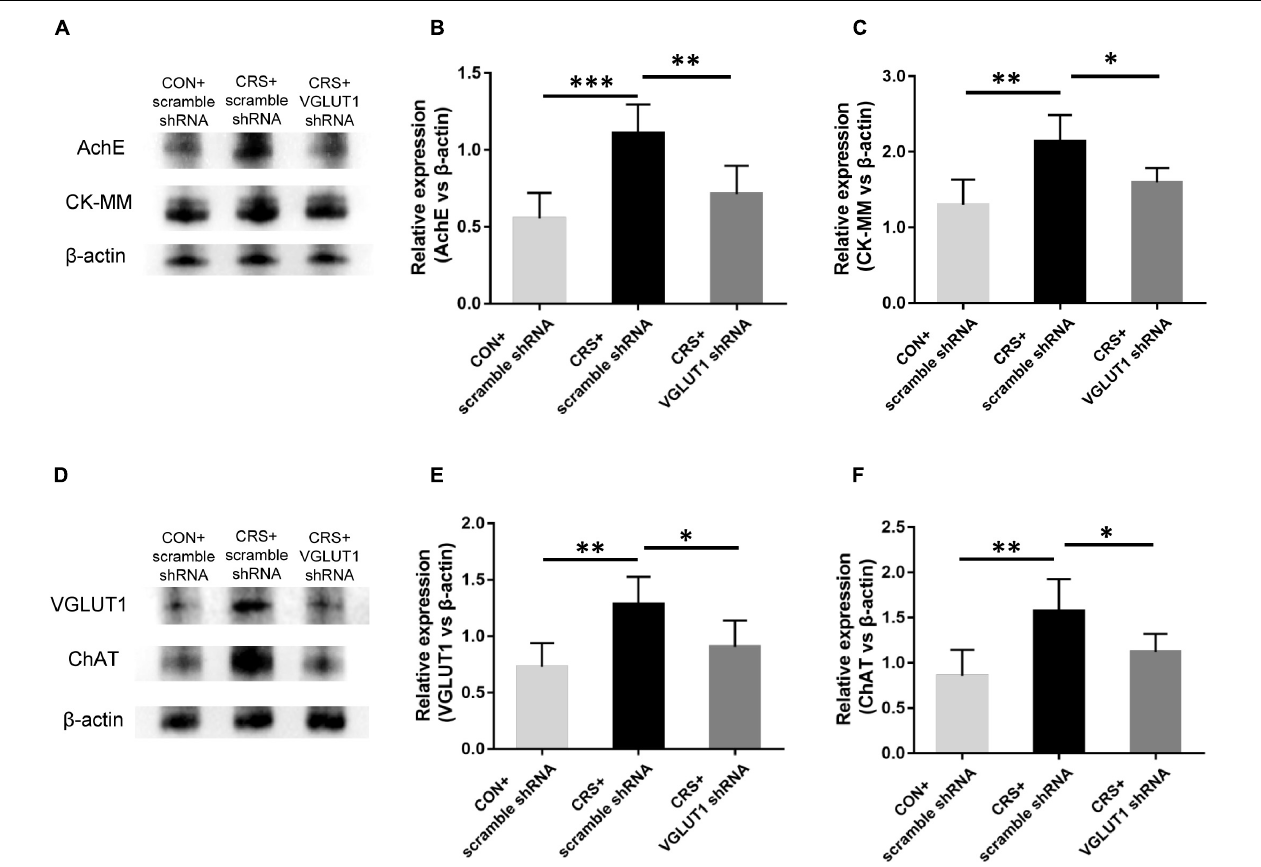
FIGURE 6 | Effects of VGLUT1 shRNA vector injections on the expression of AChE and CK-MM in the masseter and the expression of VGLUT1 and ChAT in the Vmo ( n = 5/group). (A–C) Western blotting analysis showed increased AChE and CK-MM protein levels in the masseters from CRS + scramble shRNA mice compared to CON + scramble shRNA mice. VGLUT1 shRNA vector injection significantly reversed AChE and CK-MM expression in the masseter compared to that in the UAC CRS + scramble shRNA group. (D–F) Western blotting analysis indicated that VGLUT1 and ChAT expression in the Vmo in the CRS + scramble shRNA group was significantly elevated compared to that in the CON + scramble shRNA group. VGLUT1 shRNA vector injection significantly reversed VGLUT1 and ChAT expression in the Vmo compared to that in the UAC CRS + scramble shRNA group. ∗ P < 0.05, ∗∗ P < 0.01, ∗∗∗ P <